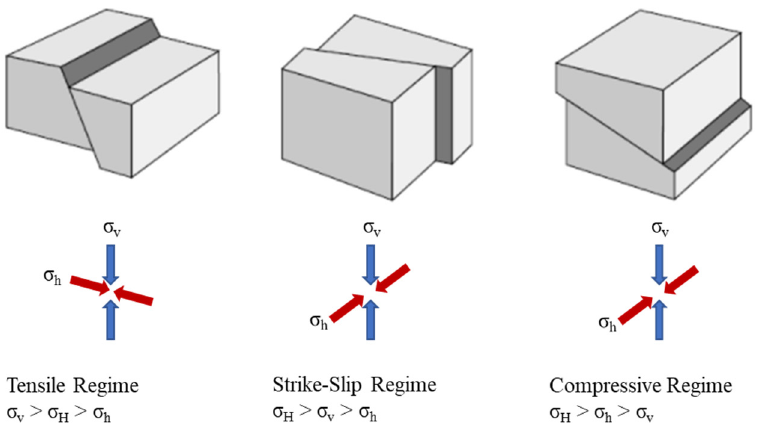
Figure 13. Schematic representation of different stress regimes and the principal stress directions based on Anderson’s classification.